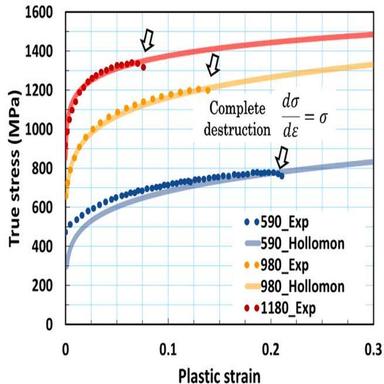
Fitted curve of true stress and plastic strain by using Hollomon approxiamation.